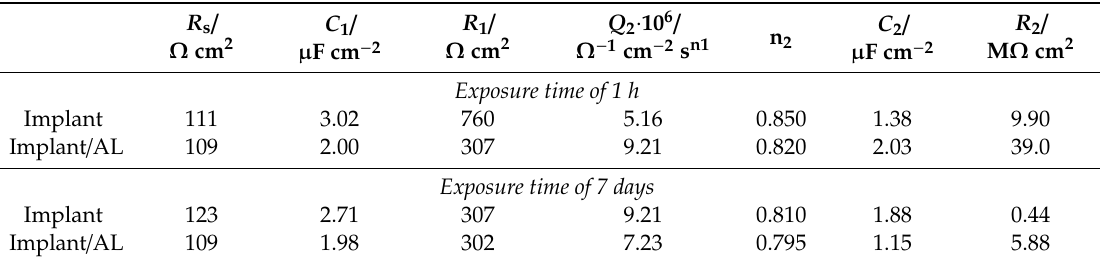
Table 2. Impedance parameters calculated from EIS data (Figure 5) for the as-received implant (Implant) and the alendronate-modified implant (Implant /